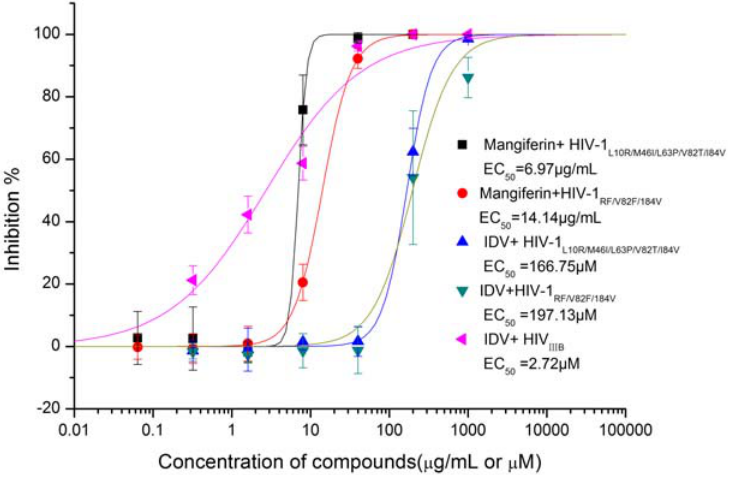
Figure 4. Inhibition of mangiferin and IDV on HIV-1 PR gene